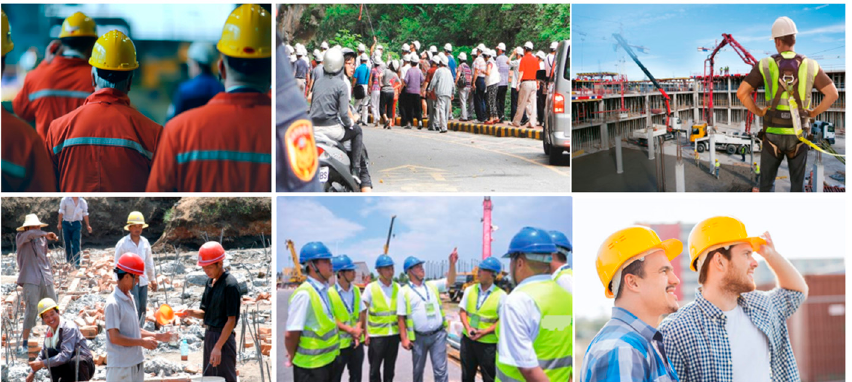
Figure 3. Dataset